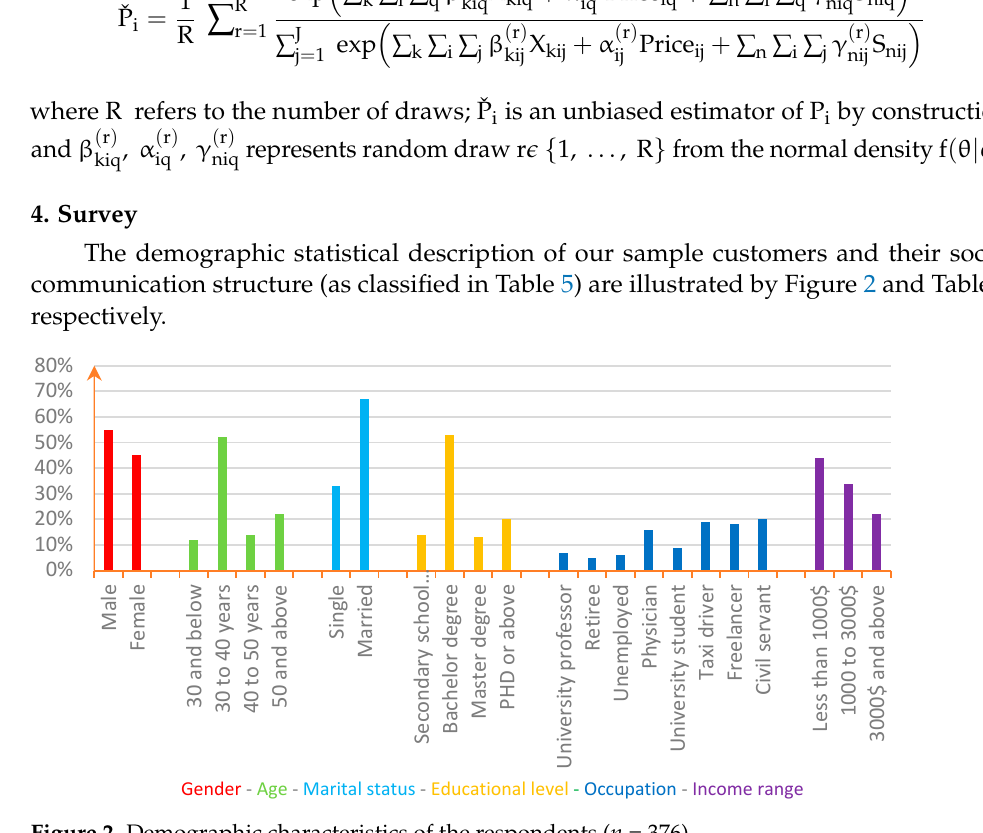
Figure 2. Demographic characteristics of the respondents ( n = 376). Table 7. Status of social